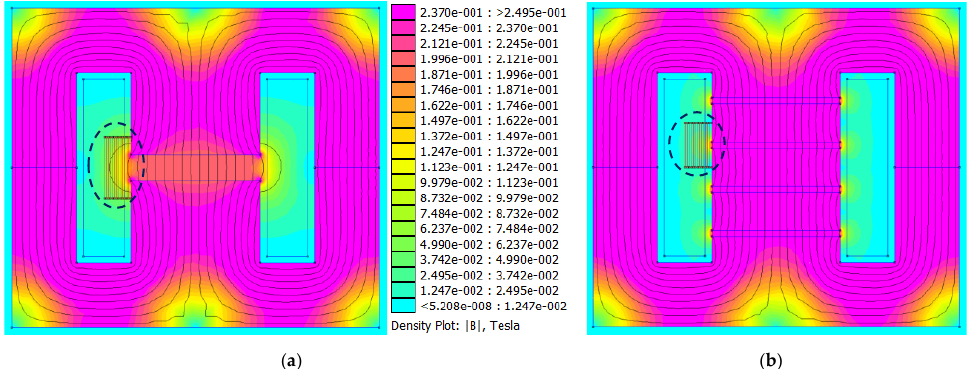
Figure 4. Comparison of the magnetic flux distribution within the magnetic circuit of an inductor with E-core for ( a ) one air gap and for ( b ) distributed air gap. The evaluation of magnetic field distribution around the air gaps of analyzed solu- tions was performed for a certain area of the air gap (distance from the air gap and length along the air gap). This is represented by the situation shown in Figure 5. Consequently, a comparison of the amplitudes of magnetic induction within the analyzed area is graph- ically interpreted in Figure 6 for one air gap situation and in Figure 7 for a distributed air gap.